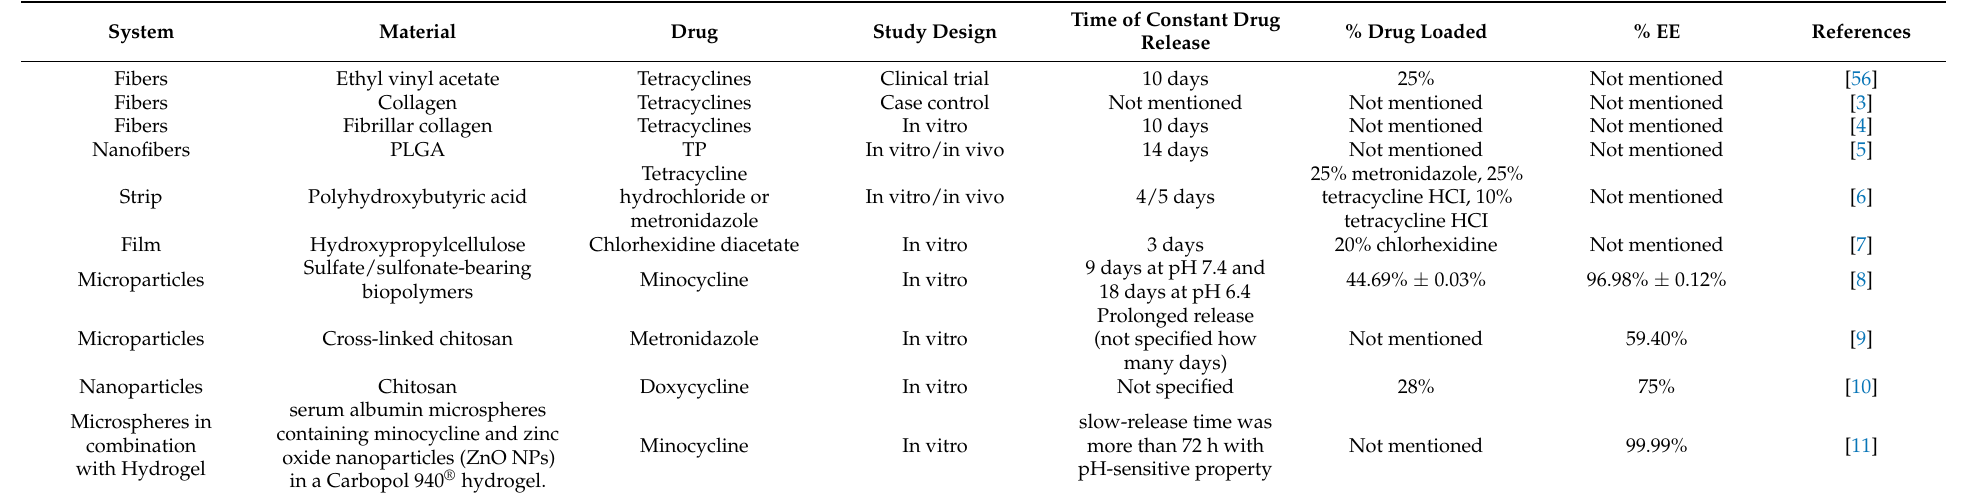
Table 4. A summary of the characteristics of some of the studies that are reported in the